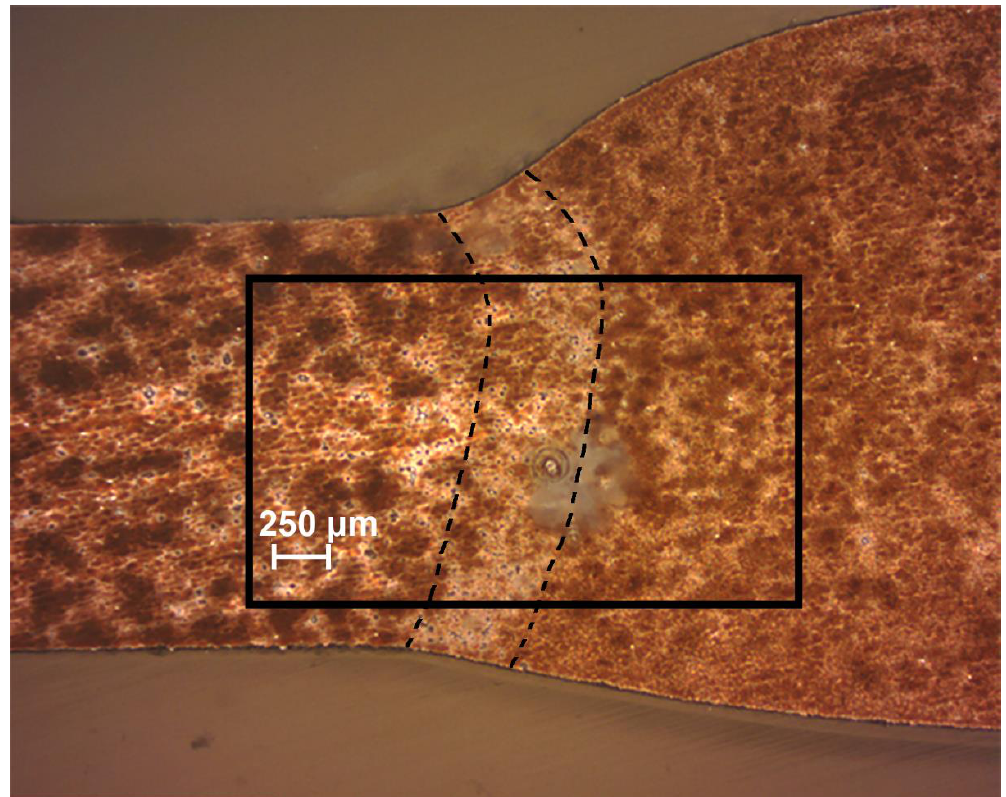
Figure 6. The optical image of the investigated welded joint area of the 1579 aluminium alloy sample with PEO-coating after SVET and SIET experiments (after 98 h of specimen exposure). The investigated area is outlined by a frame and the border of the weld interface of the sample is marked by a dotted line. There is a pitting at the weld interface.